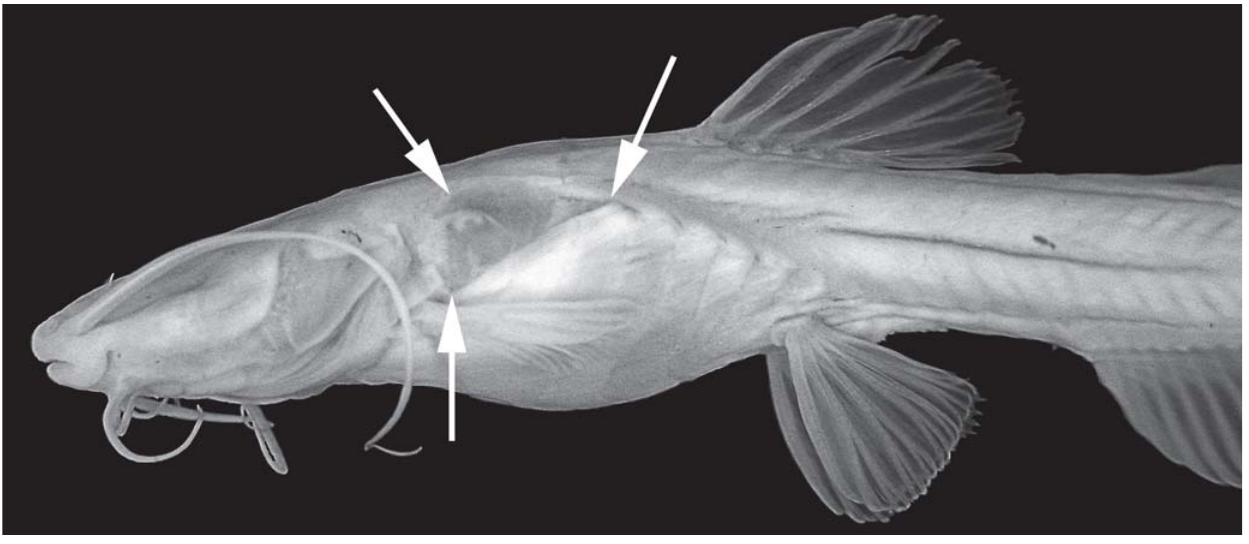
Fig. 2. Anterior portion of the body of Rhamdiopsis krugi , LIRP 5929, 37.1 mm SL, holotype. Arrows indicate the limits of the